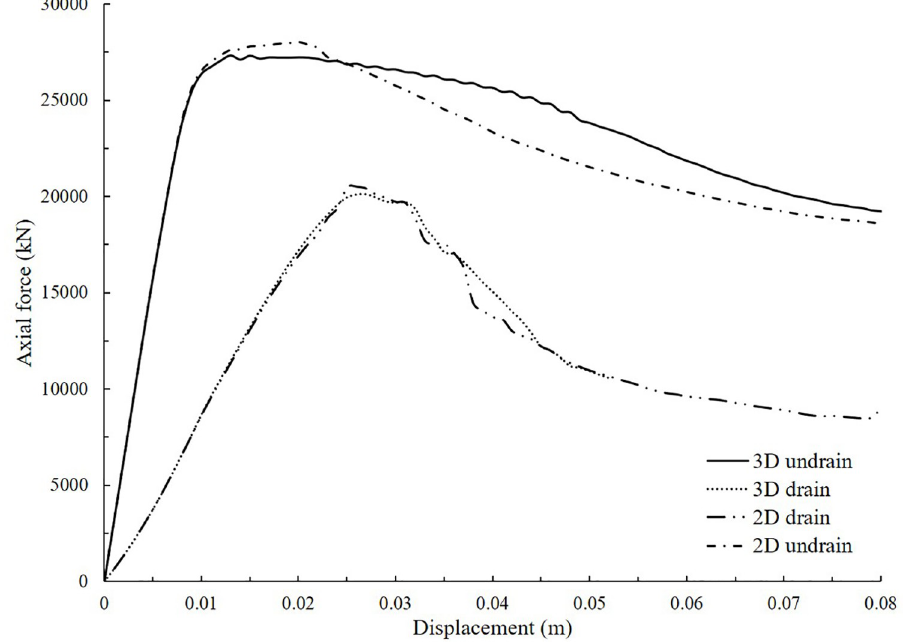
Fig 3. Comparison of 2D and 3D numerical results in drained and undrained